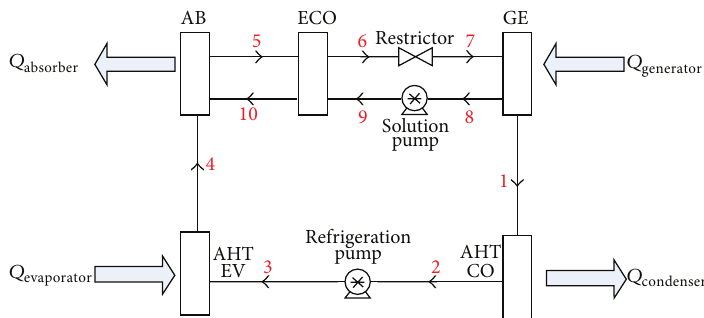
Figure 1: Schematic diagram of a single stage absorption heat transformer.